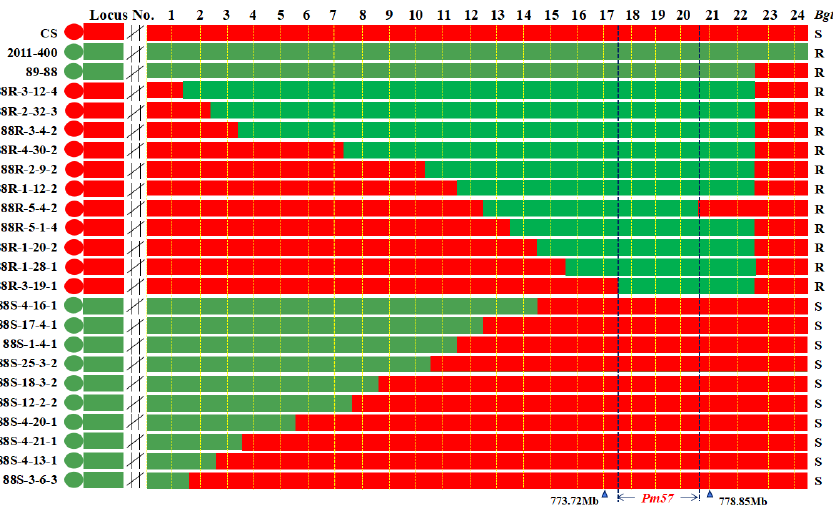
Figure 5. Molecular marker and Bgt -response among different CS- Ae . s earsii 2S s #1 recombinant lines. Markers at loci 1-24 are listed in Table 2. Genomic positions are corresponding to chromosome 2B of CS RefSeq v1.1 (IWGSC, 2018). Molecular markers (1-24) sequences, derived unigenes, and fraction length intervals are in Supplementary Table S5. Only 21 recombinant types which include 11 resistant and 10 susceptible recombinants from 46 newly identified CS- Ae . searsii recombinants are displayed (Supplementary Table S6). The chromatin of Ae . searsii is in green color and wheat in red. The genomic region, flanked by markers X67593 at 773.72 Mb at locus 17 and X62492 at 778.85 Mb at locus 21, is shared by all the resistant recombinants, but absent in all susceptible recombinants, thus delimiting Pm57 to the 5.13 Mb genomic region.